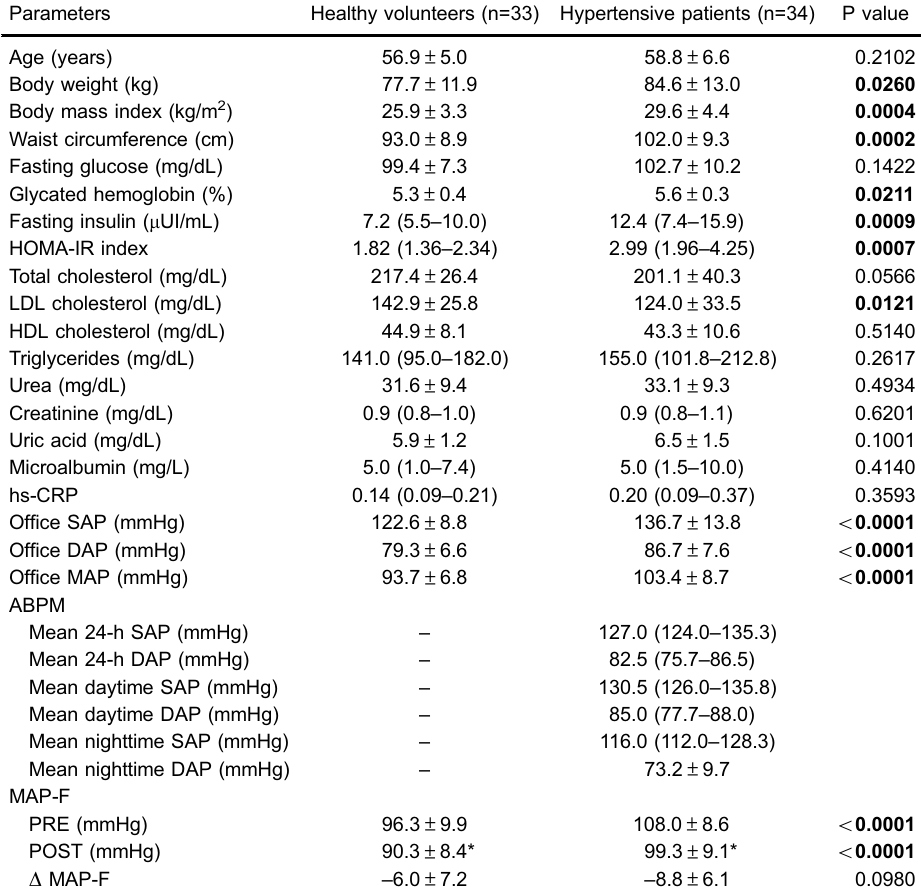
Table 1. Characteristics of healthy volunteers and hypertensive patients.